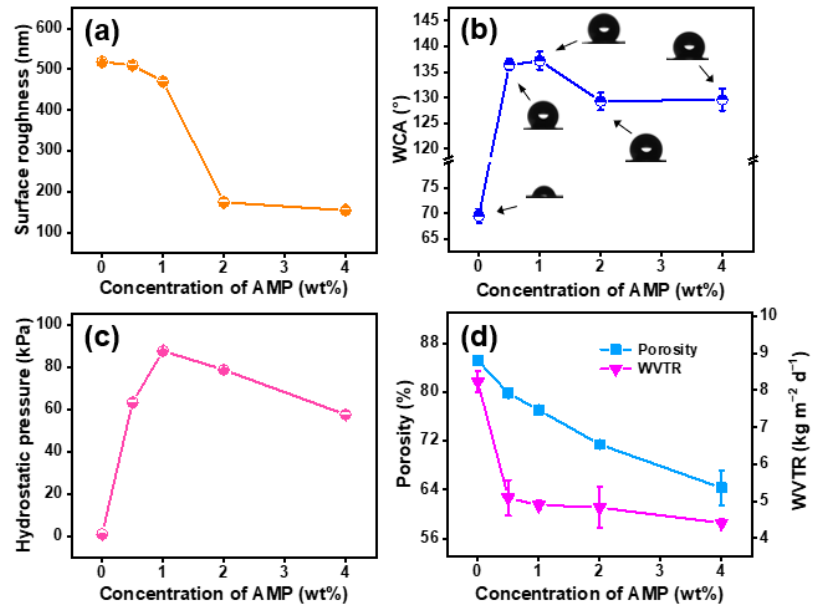
Figure 4. Surface wettability and waterproof breathable permeability of hydrophobically-modified PAN@AMP membranes with different concentrations of AMP: ( a ) Ra values, ( b ) contact angle, ( c ) hydrostatic pressure, ( d ) porosity and WVTR.